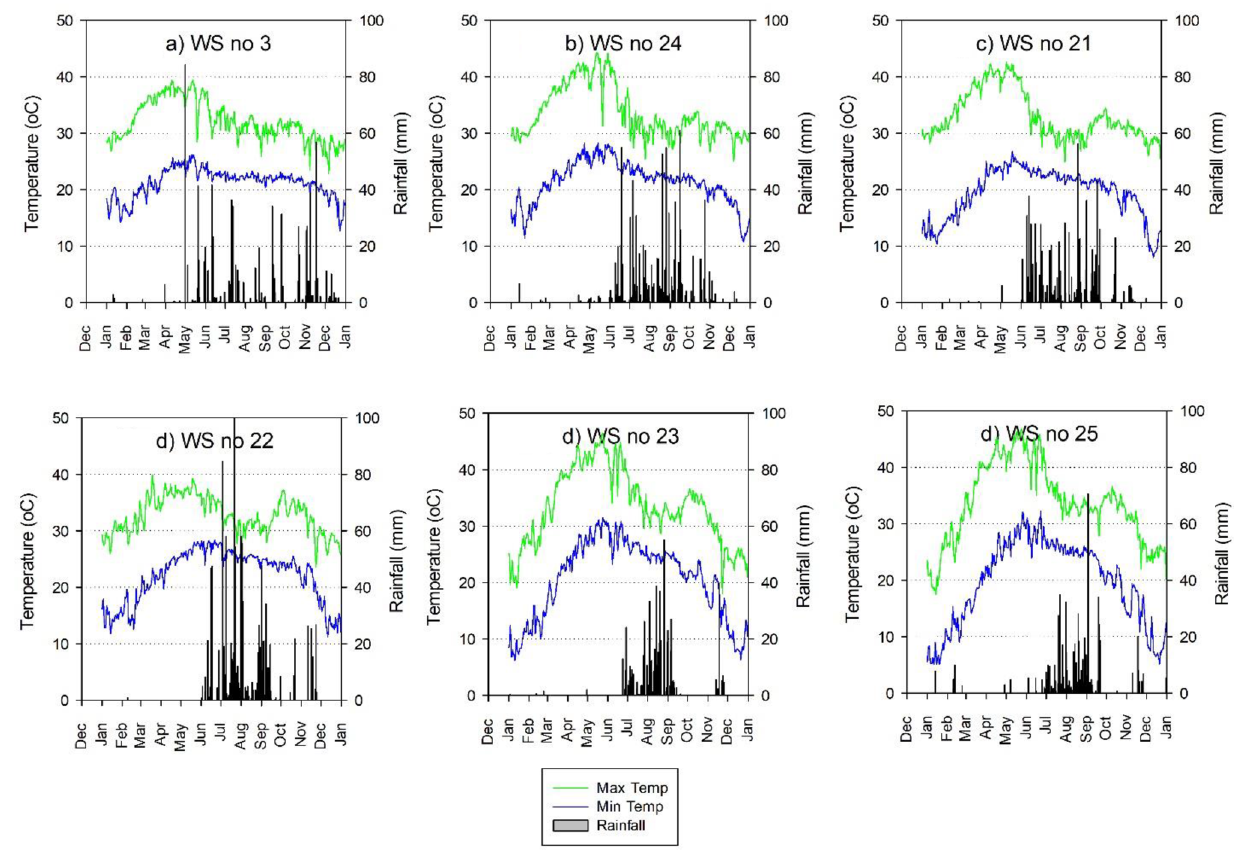
Figure 5. Variability in rainfall and maximum and minimum temperature in selected watershed locations in 2010.